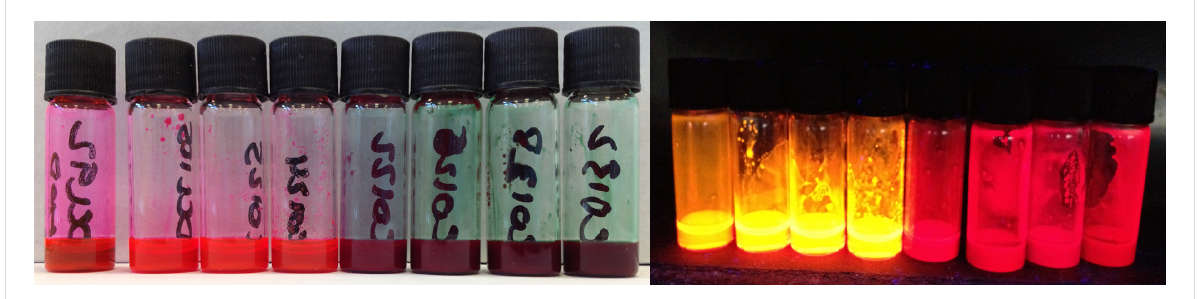
Figure 2: The samples of oligofluorene BODIPY solutions in toluene under ambient light (left) and UV illumination (254 nm, right). From left to right, T-B1 , T-B2 , T-B3 , T-B4 , Y-B1 , Y-B2 , Y-B3 and Y-B4 .